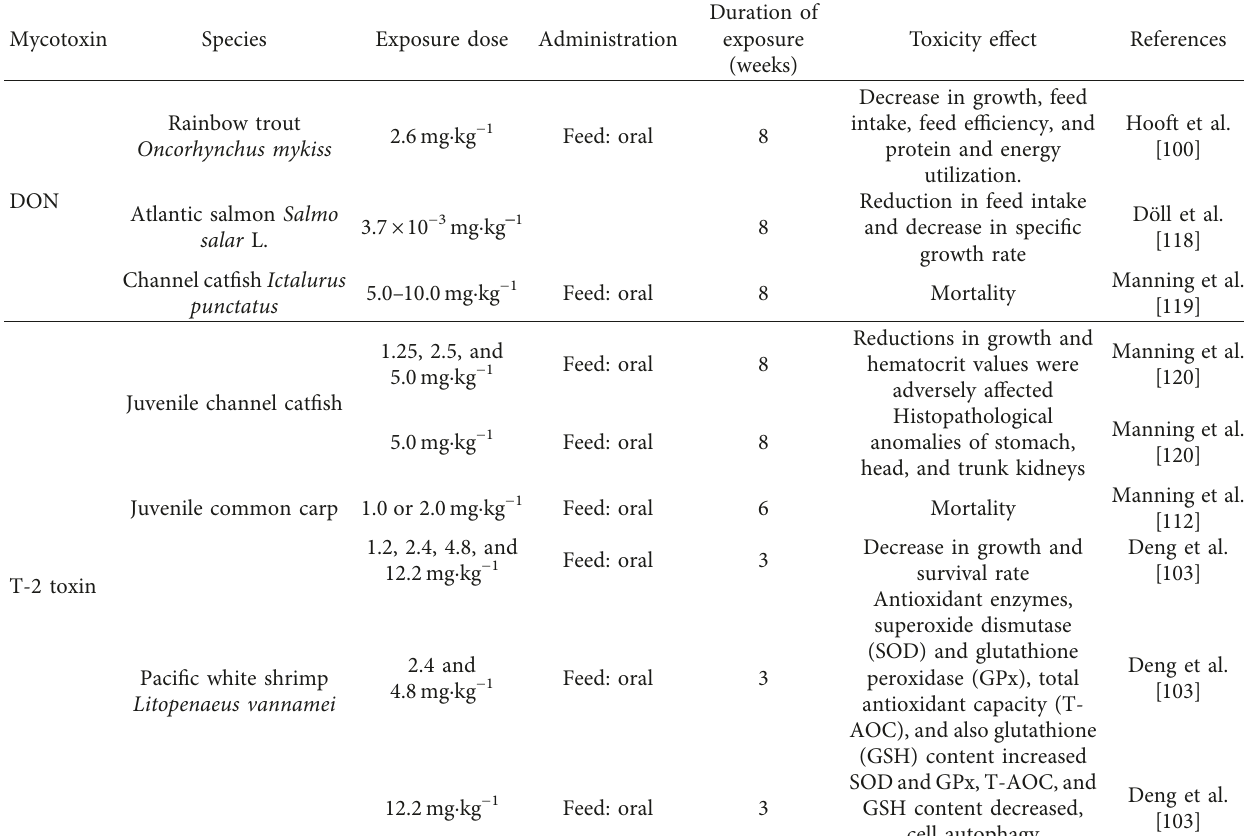
Table 4: Toxic effects of Fusarium mycotoxins in different species of